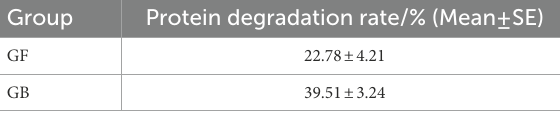
TABLE 3 Artificial feed protein degradation